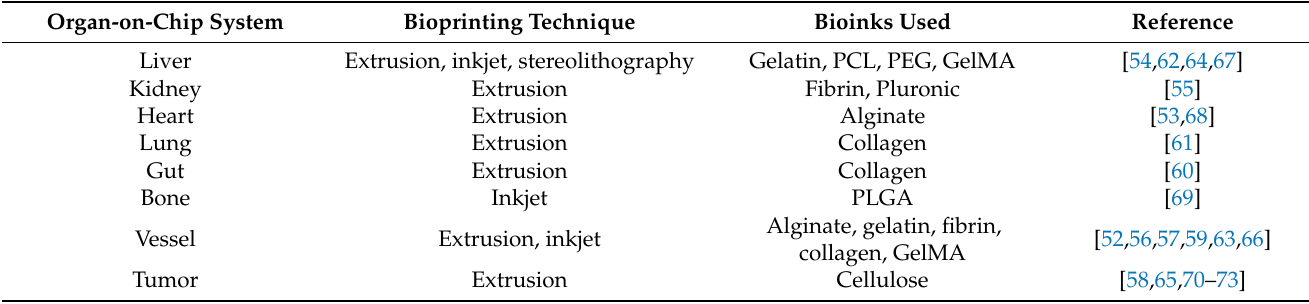
Table 2. Reported studies investigating various organ-on-chip systems.